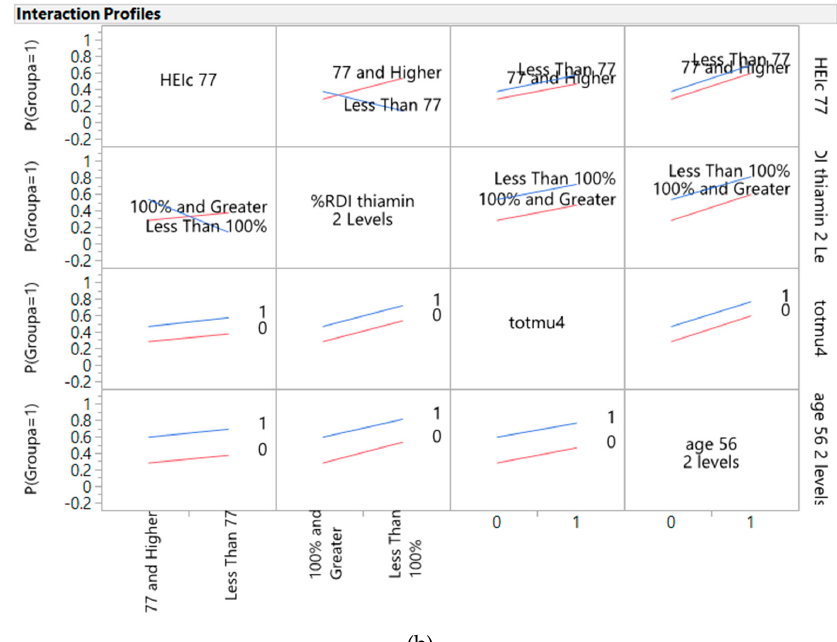
Figure 2. Gene-diet interactions relevant for the prediction of cancer: ( a ) prediction profiler, ( b ) interaction profiles (Healthy Eating Index interactions with with thiamine, with non-parallel lines for associations with cancer). Note: p (Groupa) = 1 is the probability of predicting a level 1 (cancer status versus 0, the control status) response.